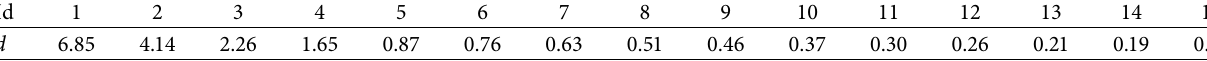
Table 4: Internode distance values corresponding to the coded modulation format of the LTE system.